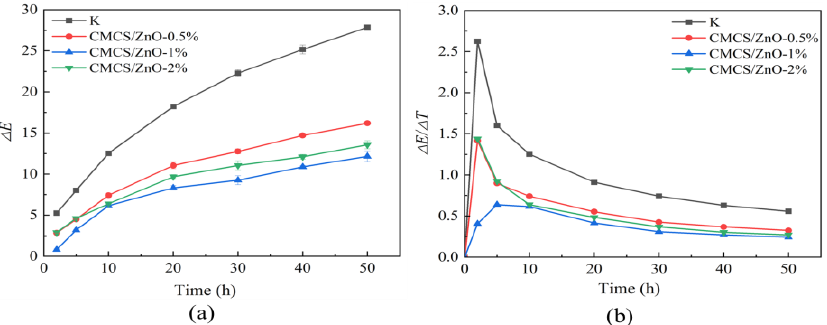
Figure 4. ∆ E changes ( a ) and color variation rates ( b ) of untreated dyed wood (K) and treated wood (CMCS/ZnO-0.5%, CMCS/ZnO-1%, and CMCS/ZnO-2%) under 200 – 800 nm UV light irradiation.